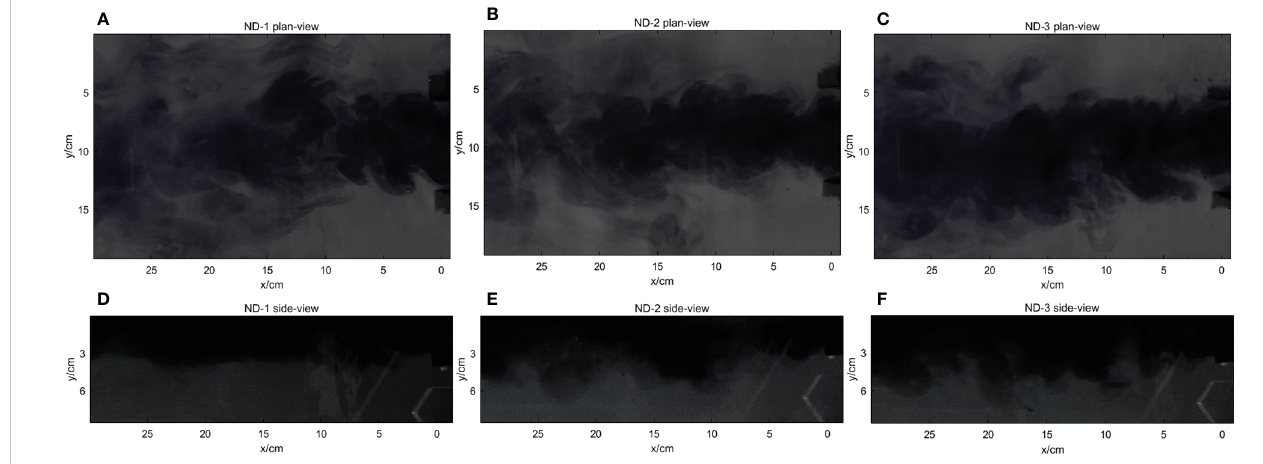
FIGURE 2 Plan and side view of plume with an ambient water density of 0.9997g/cm 3 : plan-view of Case ND-1,ND-2 and ND-3 (A – C) ,side-view of Case ND-1,ND-2 and ND-3 (D – F) .